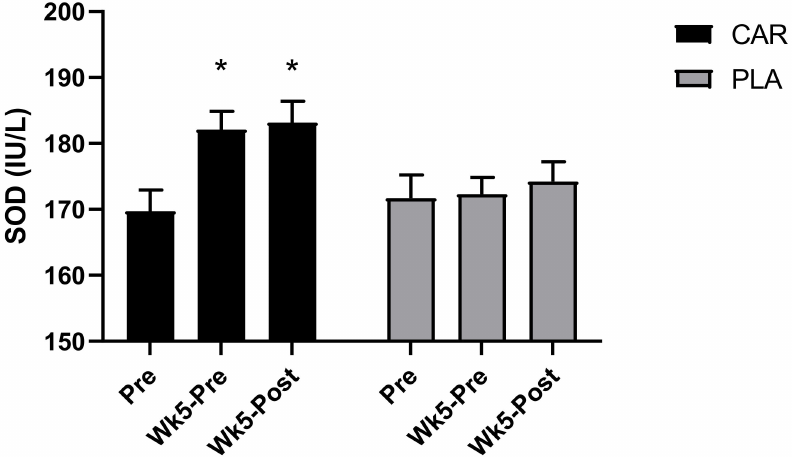
Figure 5. Serum superoxide dismutase (SOD). Bar chart for the mean values and error bars for the standard error of the mean for serum super oxide dismutase (SOD) are shown. * indicates a significant difference from Pre ( p < 0.001). The groups are carnitine (CAR) and placebo